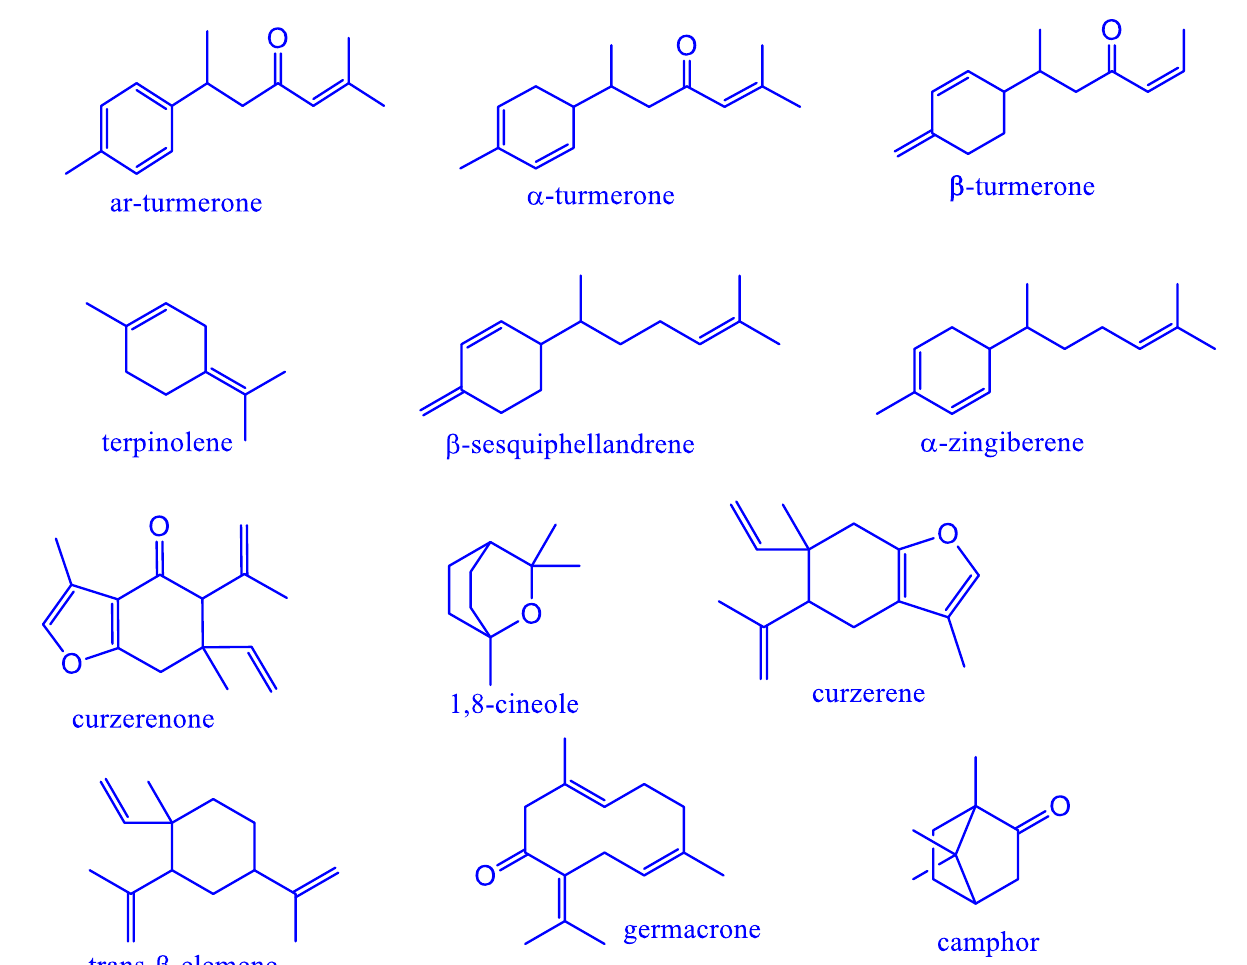
Figure 1. Major compounds present in C. longa, C. zedoaria, and C. aeruginosa.